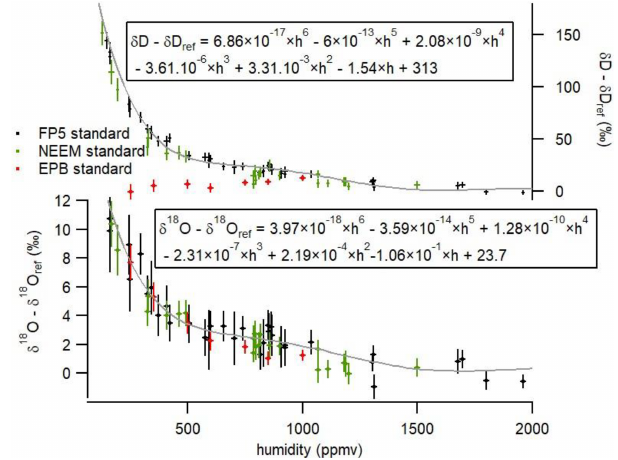
Figure 5. Influence of humidity on the isotopic composition ( δ 18 O and δ D) of the vapor obtained with the LHLG with three water lab standards. The error bars are calculated as the standard deviation (1 σ ) over the generated values by the L2130-i instrument during 10min at 1s resolution (i.e., without any pre-averaging of the raw data series). The δ 18 O and δ D ref are the values of the injected water standards at 2000ppmv. The gray lines represent the polynomial fits for the influence of humidity on the water isotopic composition (Eqs. 4 and 5 are also given on the graph).